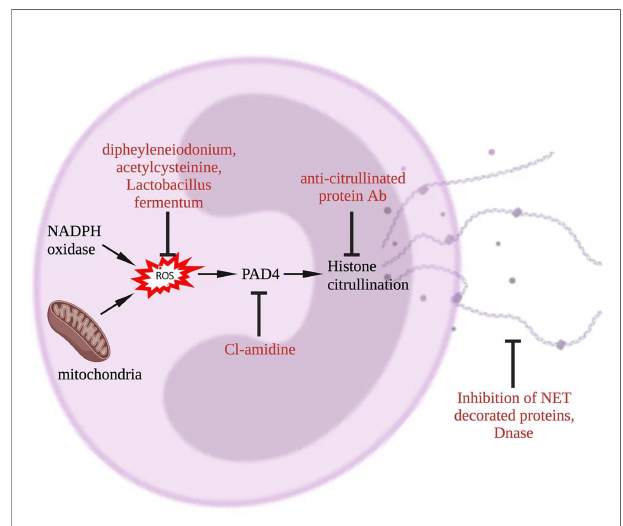
FIGURE 5 | Potential approaches to target NET in lupus. To inhibit NETosis, ROS could be reduced by diphenyleneiodonium, acetylcysteine, or Lactobacillus fermentum, PAD4 could be targeted by CL-amidine, histone citrullination could be interfered through anti-citrullinated protein Abs, and NET degradation could be promoted by DNase. Additionally, NET-decorated proteins, such as interleukin-17A and tissue factor, could be targeted alternatively. Abs, antibodies; NADPH, nicotinamide adenine dinucleotide phosphate hydrogen; DNase, deoxyribonuclease; NET, neutrophil extracellular trap; PAD, peptidyl arginase deaminase; ROS, reactive oxygen